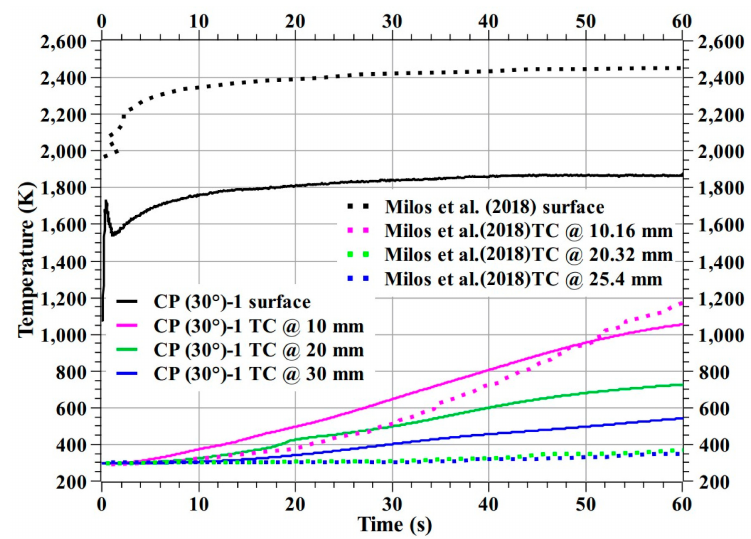
Figure 32. Comparison of CP (30 ◦ )-1 and NASA’s dual-layer woven carbon phenolic temperature responses [28].